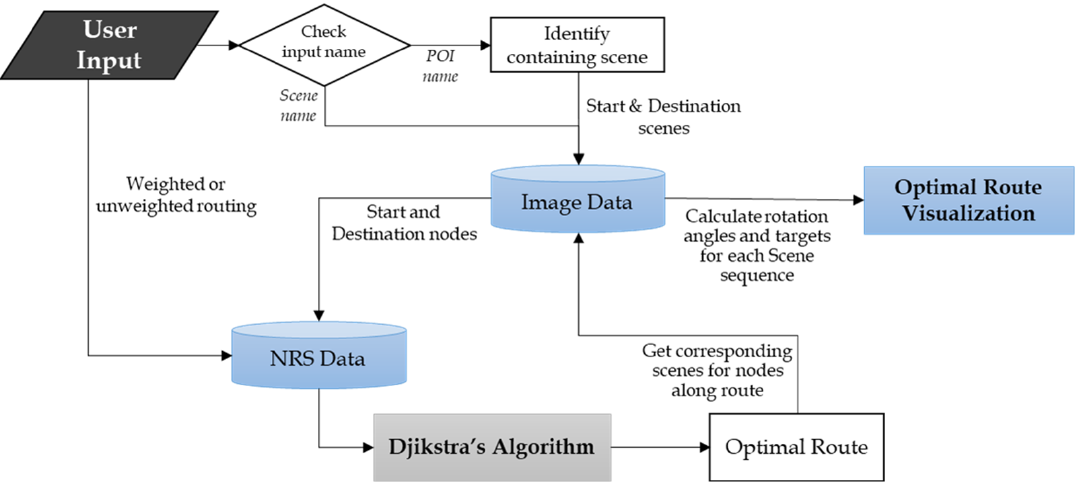
Figure 12. Process for using the images for automated navigation based on the route calculated on the extracted NRS data.